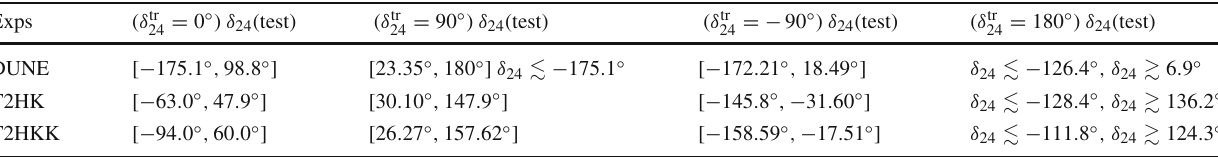
Table 1 The 2 σ allowed ranges of δ 24 (test) for the three experiments in the 3 + 1 scenario. The assumed true value of δ 13 is − 90 ◦ . We give